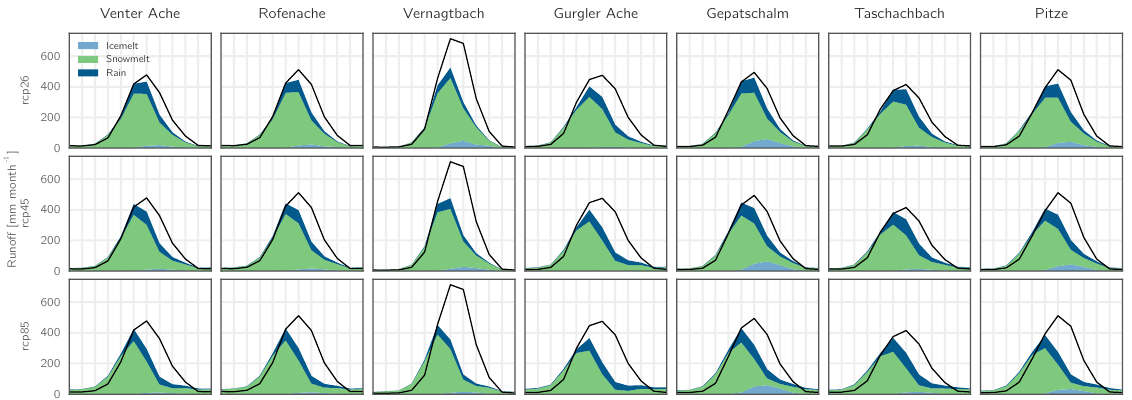
Figure 17. Average monthly runoff and composition (multi-model mean) for the period 2071–2100. The black lines show the average runoff in the historical period